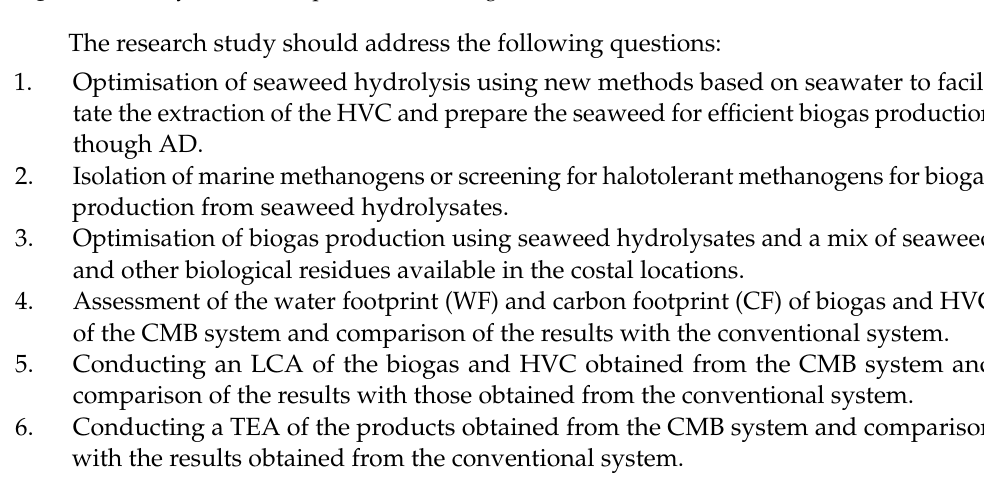
Figure 4. CMB system for the production of biogas (Route